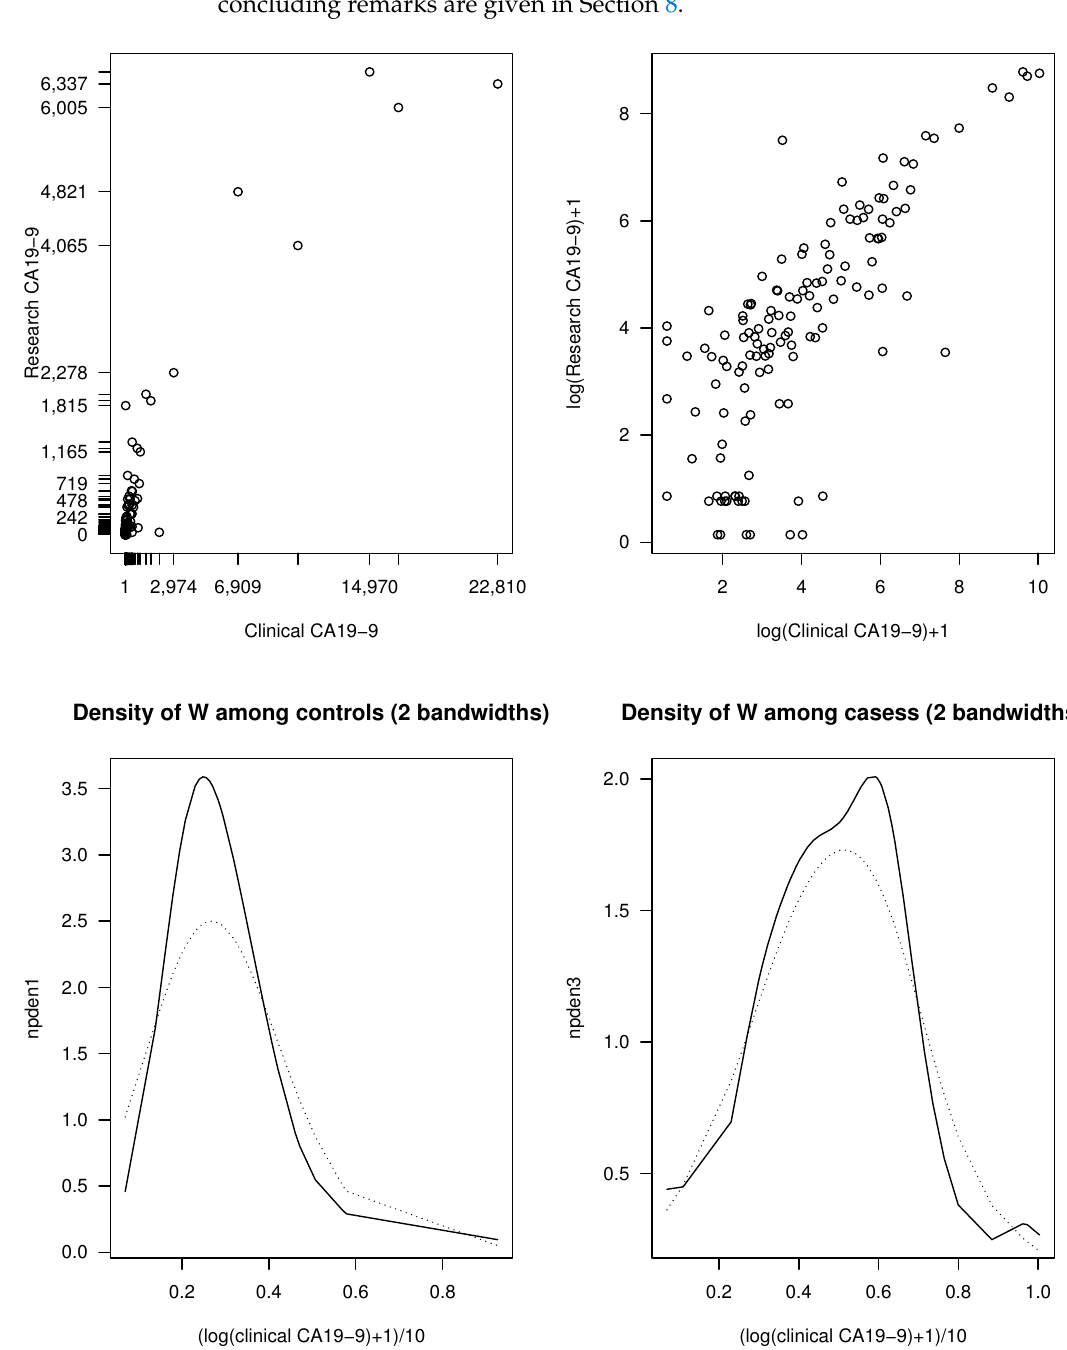
Figure 1. Upper : clinical assay versus research assay; lower : density estimation of log(clinical CA19-9 + 1)/10 based on two bandwidths (dotted curves from wider bandwidth)